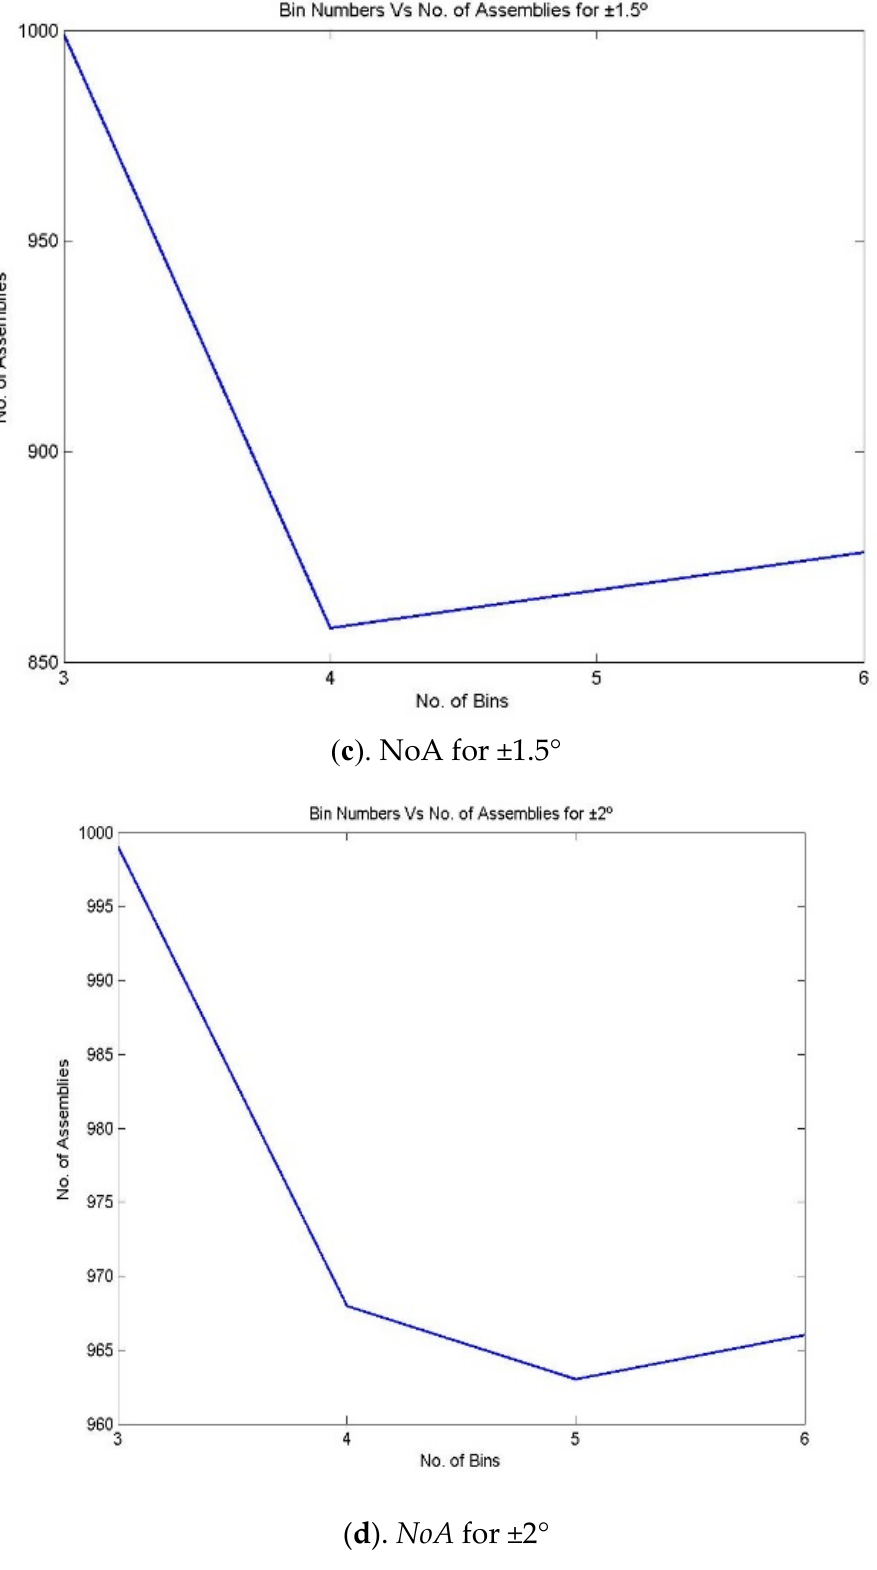
Figure 5. NoA for various bin numbers and assembly specifications for the 3213 process combina- tion (a) NoA for ± 0.5°, (b) NoA for ± 1°, (c). NoA for ± 1.5° and (d) NoA for ± 2°